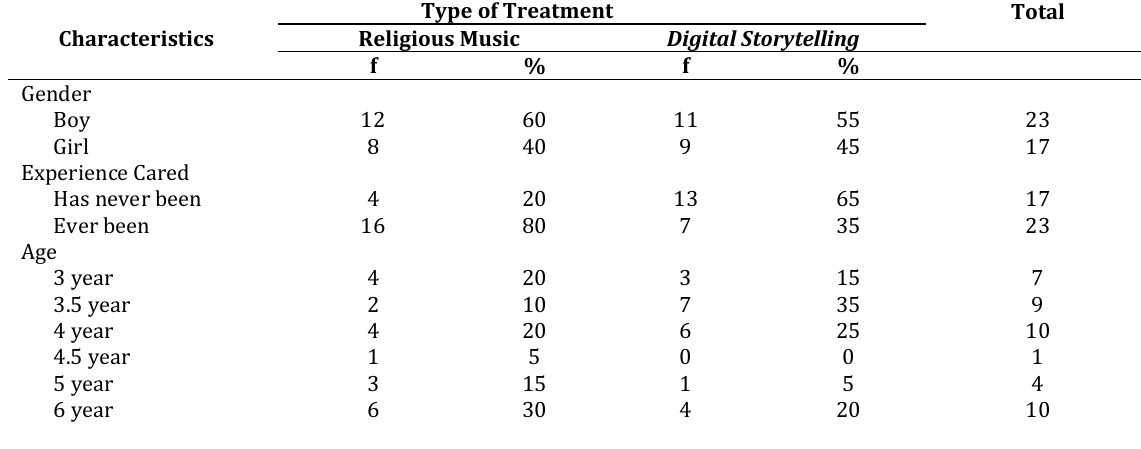
Table 1 Characteristics of Respondents Type of Treatment Total Characteristics Religious Music